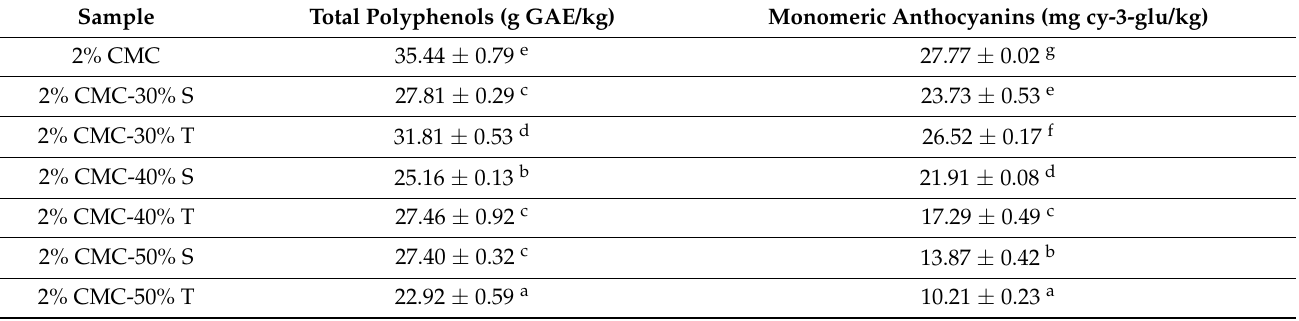
Table 4. Total polyphenols and monomeric anthocyanins of chokeberry hydrogels and chokeberry juice after